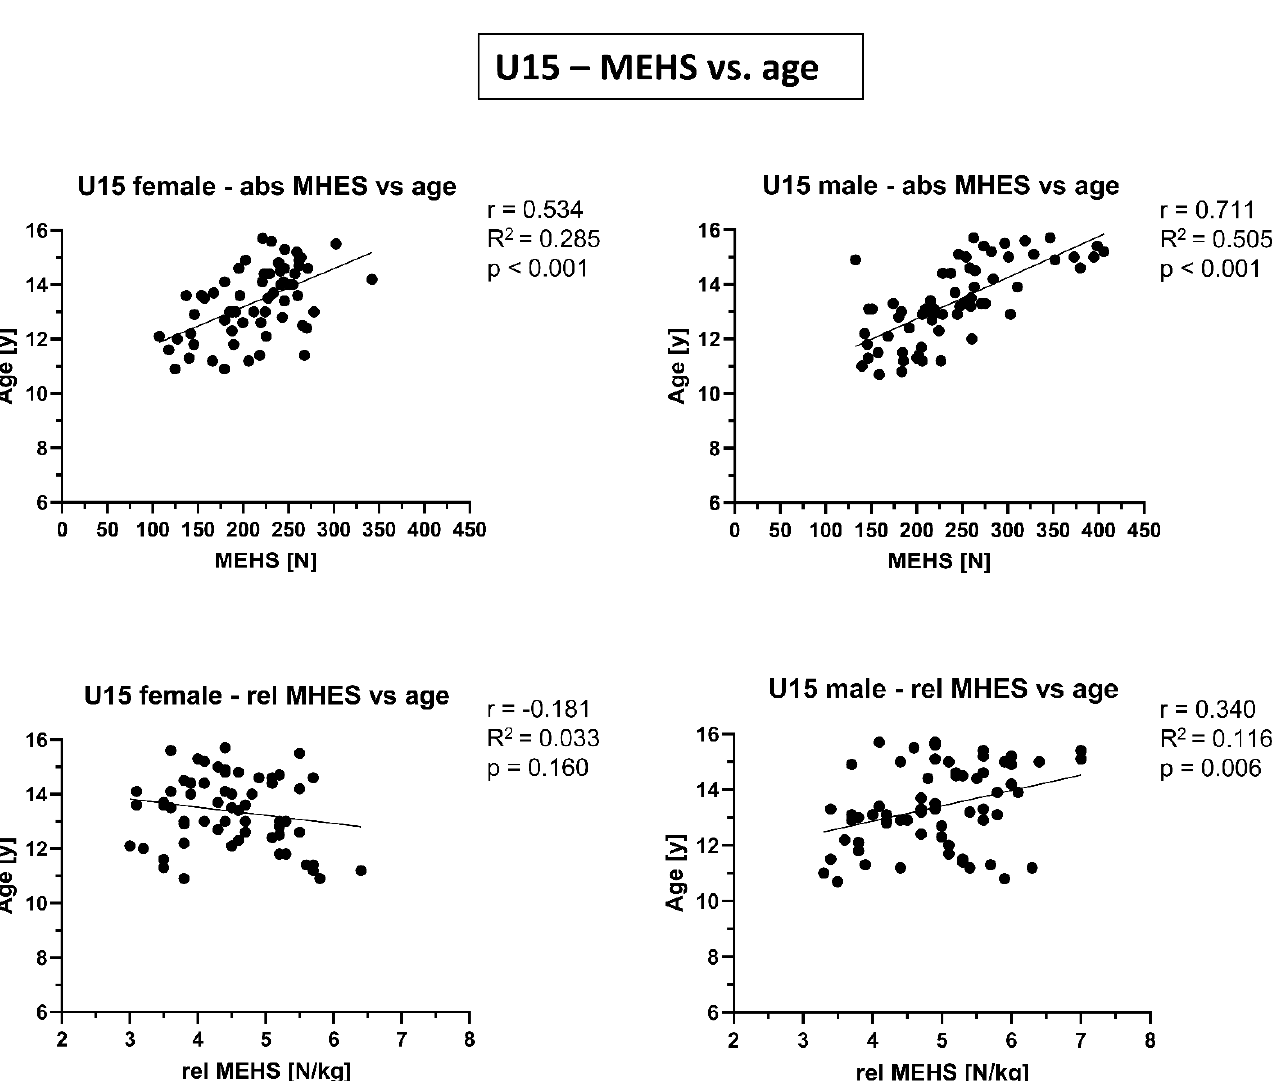
Figure 3. Correlations of absolute (abs) and relative (rel) maximal eccentric hamstring strength (MEHS) with age for competitive alpine skiers under 15 years old (U15) separated by sex.